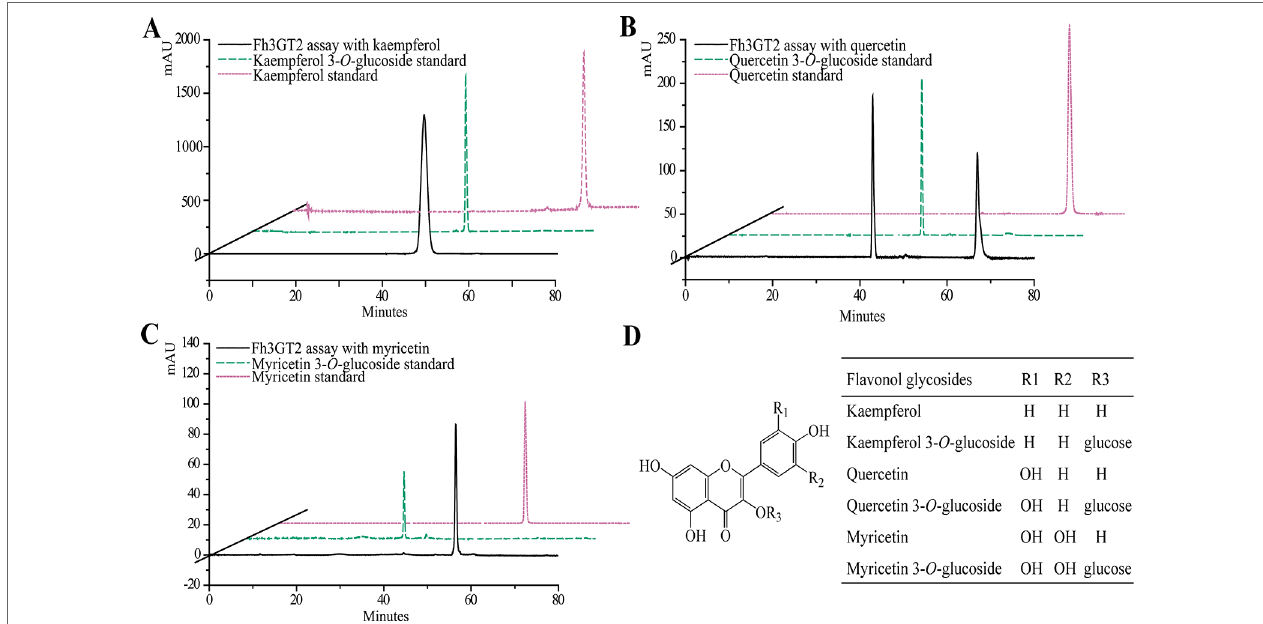
FIGURE 3 | In vitro enzyme activity assays of Fh3GT2 towards flavonol aglycones. (A – C) In vitro enzyme activity assays of Fh3GT2 towards kaempferol, quercetin, and myricetin, respectively. (D) Molecular structures of flavonol derivatives. The recombinant Fh3GT2 extracted from Escherichia coli was reacted with UDP-glucose and flavonol aglycones. Identification of the products was confirmed based on the standard substance and the relative retention